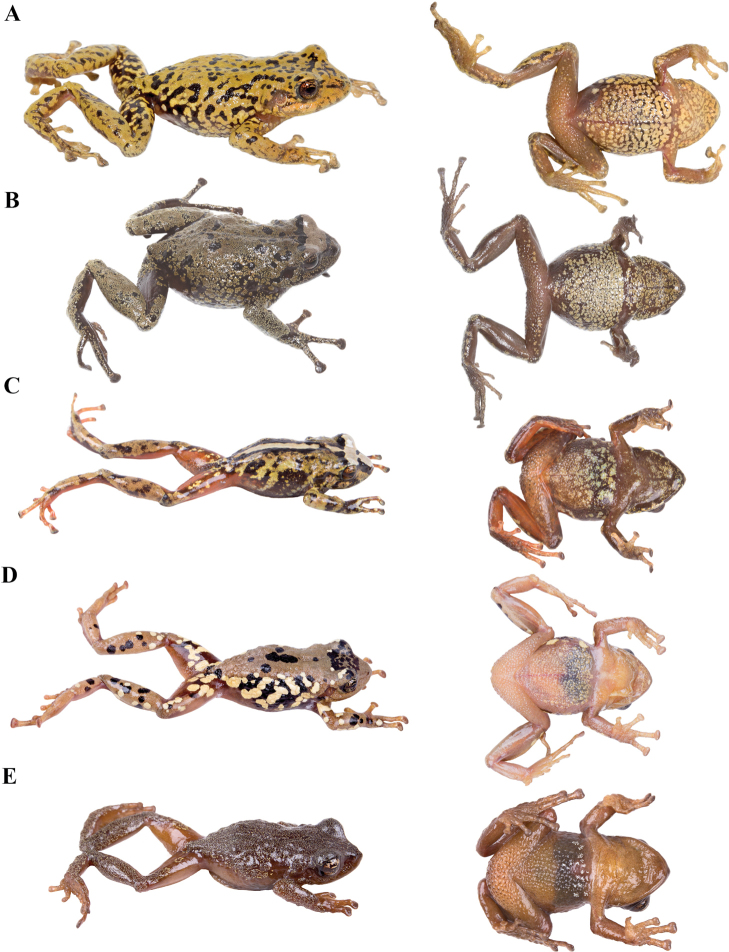
Color variation in live individuals of Pristimantis
multicolor sp. nov. AQCAZ 61283 (female, SVL 32 mm) BQCAZ 61304 (female, SVL 34.6 mm) CQCAZ 61373 (male, SVL 21.8 mm) DQCAZ 61381 (male, SVL 29.2 mm) EQCAZ 61418 (male, SVL 24.5 mm). Dorsolateral view on the left, ventral view on the right.